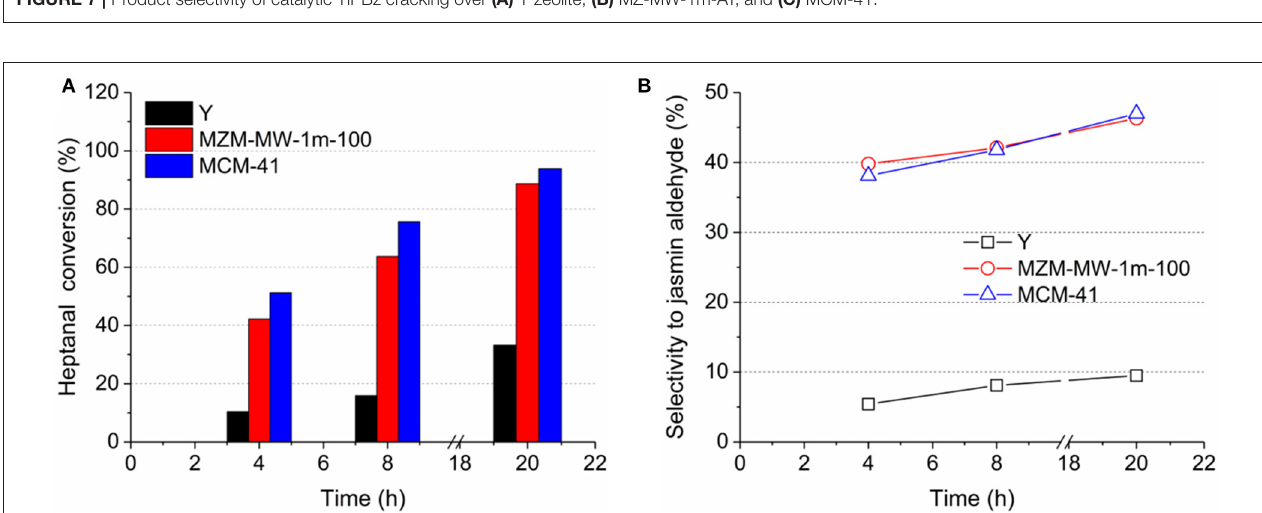
FIGURE 8 | (A) conversion of 1-heptanal and (B) selectivity to jasmin aldehyde as a function of reaction time in aldol condensation over the parent Y zeolite, MZM-MW-1m-100, and